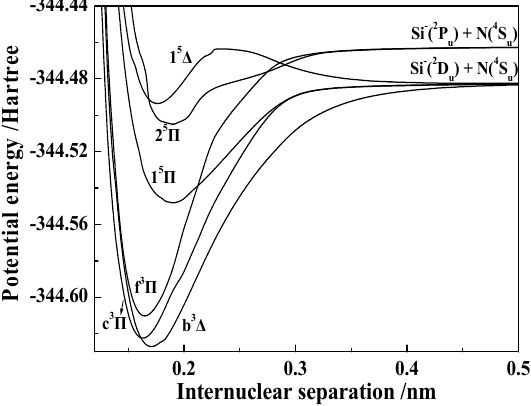
Figure 2. PECs of the 6 Λ -S states with the Π and Δ symmetries of the SiN − anion.